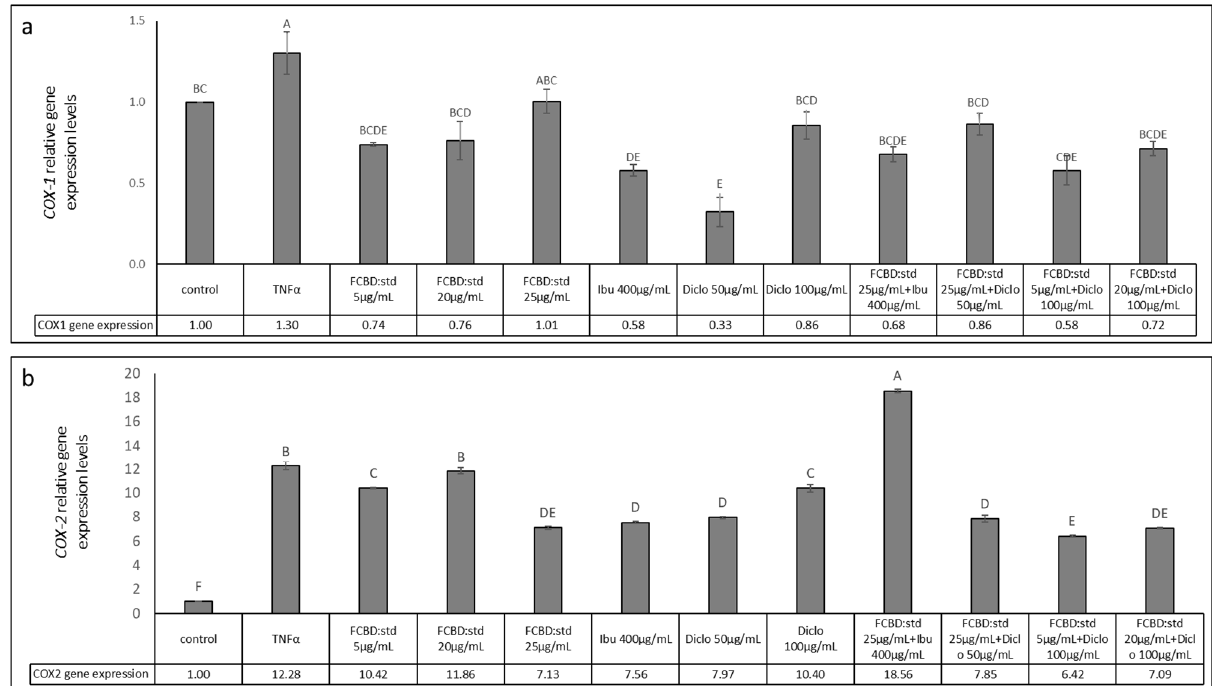
Figure 6. Determination of the RNA steady-state level using quantitative PCR-based in co-culture of A549 and differentiated KG1 cell line of ( a ) COX-1 , ( b ) COX-2 after treatment with FCBD:std or ibuprofen (Ibu) or diclofenac (Diclo) and their combinations, for 2 h relative to control. Quantitative PCR determined gene transcript values as a ratio between the target gene versus β-actin as a reference gene. Using the 2 ΔΔCt method, values were calculated relative to the average expression of target genes in treated versus control . Control (1% methanol) treatment served as solvent (vehicle) control. TNFα is solvent control+ TNFα. Means ± SE ( n = 3) are shown. Levels with different letters are significantly different from all pairs’ combinations by the Tukey–Kramer honest significant difference test (HSD; p ≤ 0.05).